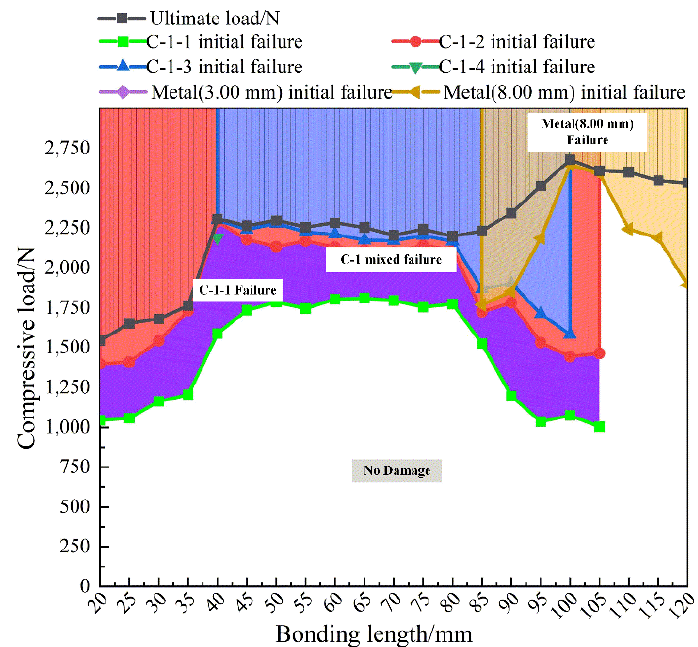
Figure 17. Damage and failure prediction diagram for metal-composite L-joints.